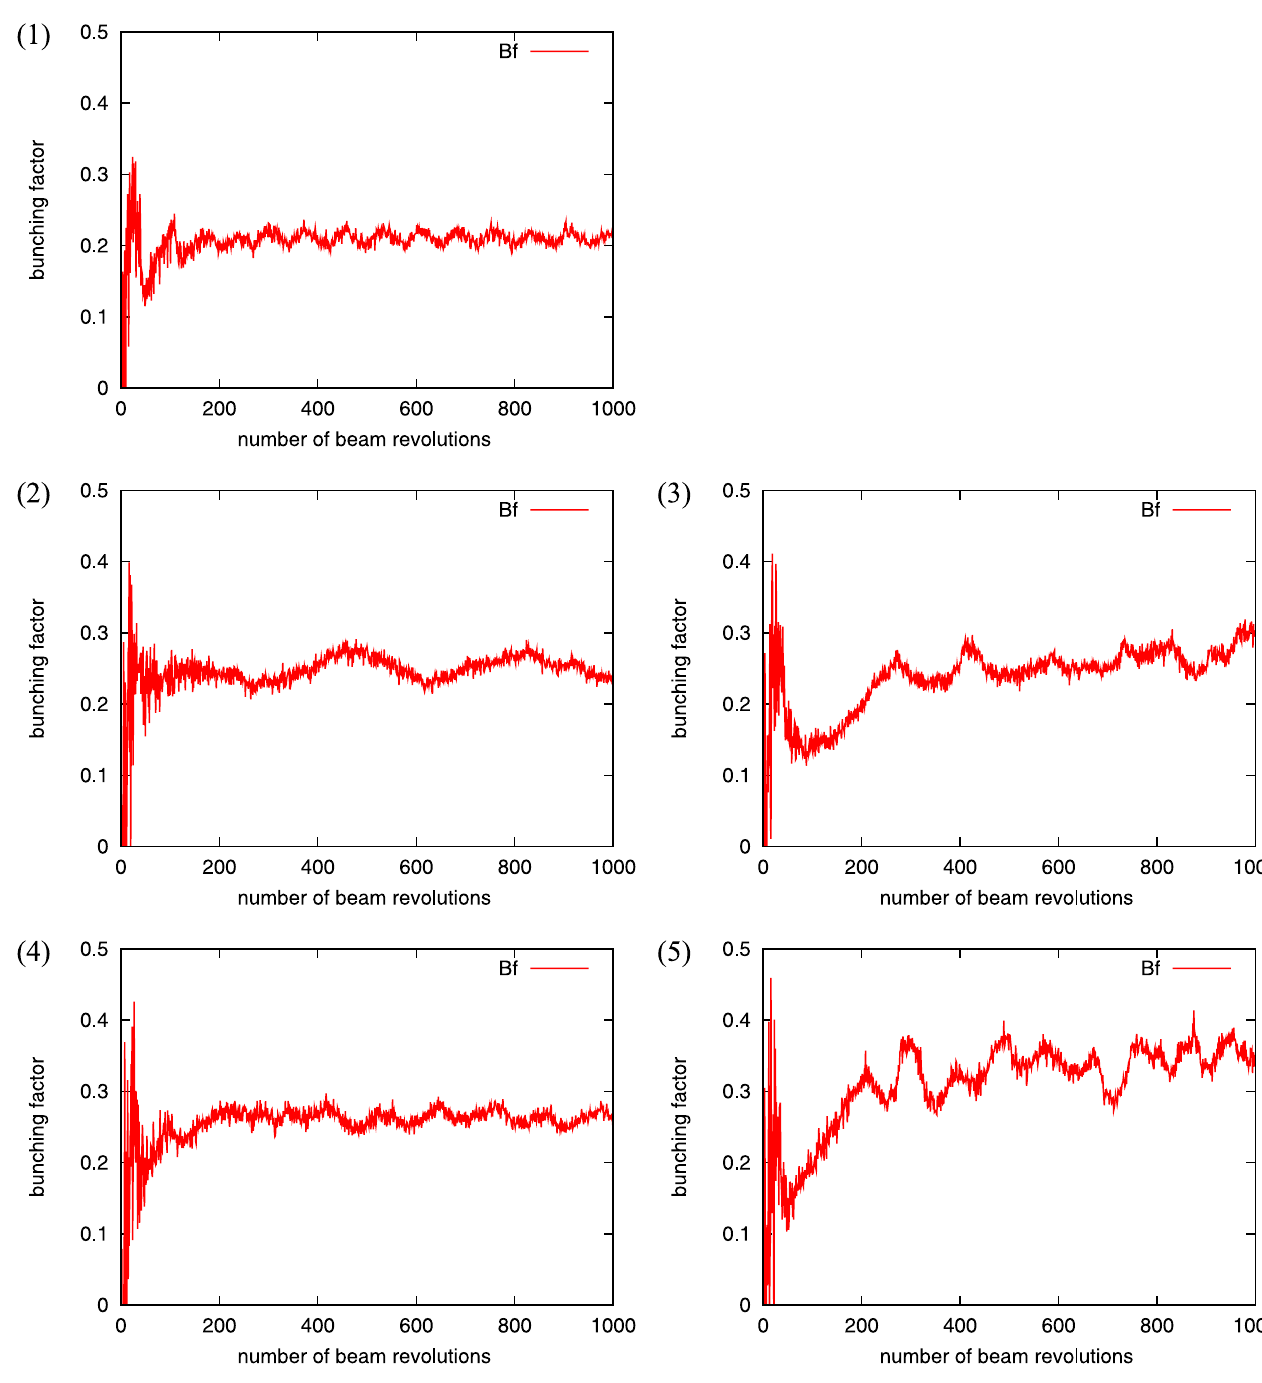
FIG. 5. (Color) Bunching factor plots corresponding to Fig. 4. (upper left) (1) Fundamental rf only; (middle left) (2) with 50% second harmonic to the fundamental; (middle right) (3) with 50% second harmonic and momentum offset of (cid:1) 0 : 2% ; (lower left) (4) with 80% second harmonic; (lower right) (5) with 80% second harmonic and momentum offset of (cid:1) 0 : 2%